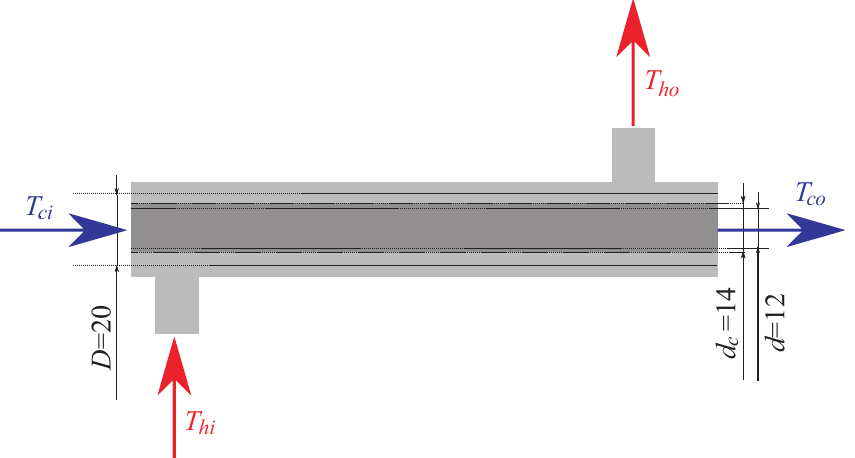
Figure 5. Scheme of parallel flow heat exchanger (dimensions are provided in millimetres).